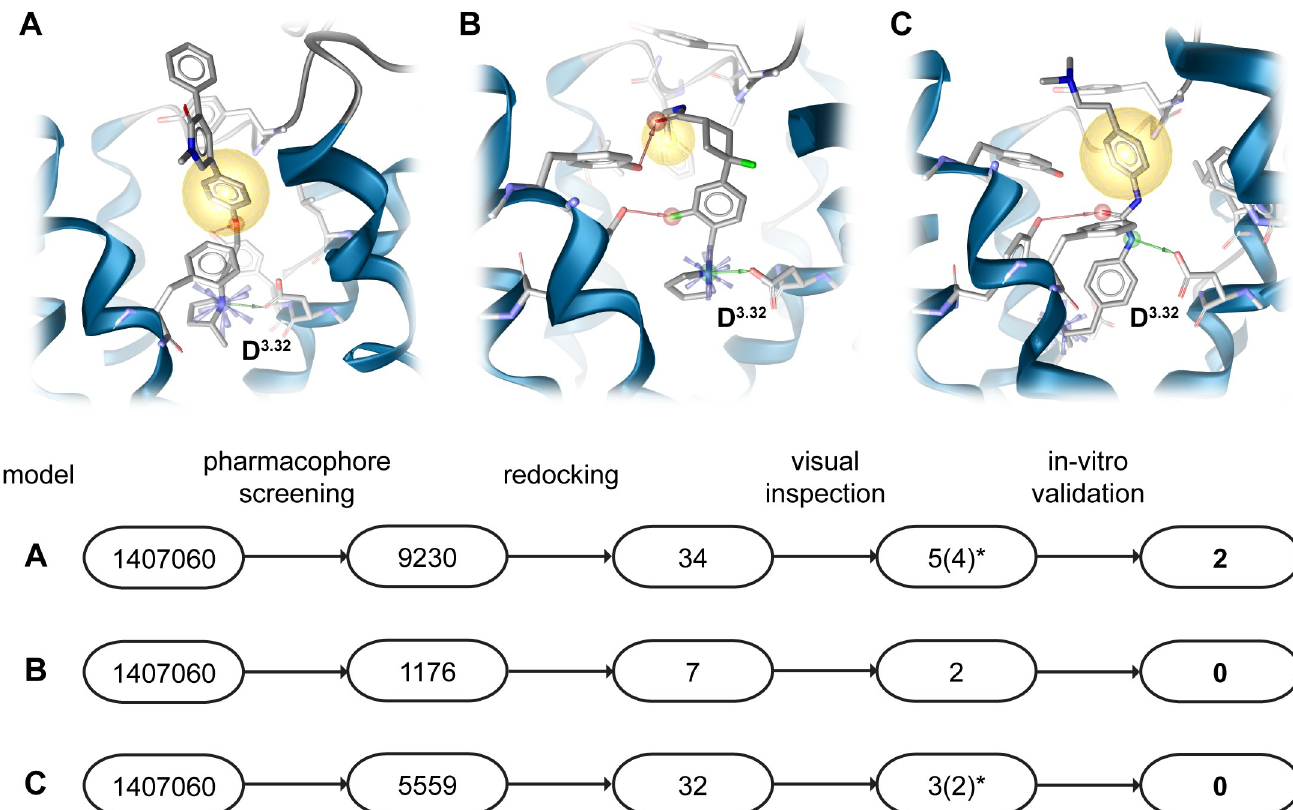
Fig 3. Virtual screening workflow results in 8 compounds out of 1.4 M for in-vitro validation. Workflow for virtual screening using 3 different pharmacophores based on docking poses of CHEMBL1923737 (model A), CHEMBL2151197 (model B) and CHEMBL2387294 (model C). Model A led to identification of compounds 3, 5, 6, 8, 9, model B to compounds 4, 7 and model C to compounds 1, 2, 10 (Fig 4, Table E in S1 File). � compounds 9 and 10 (model A and C) were removed from experimental testing due to insufficient purity as determined by LC-MS. Red arrows–hydrogen bond acceptors, green arrows–hydrogen bond donors, blue star–positive ionizable, yellow sphere–hydrophobic